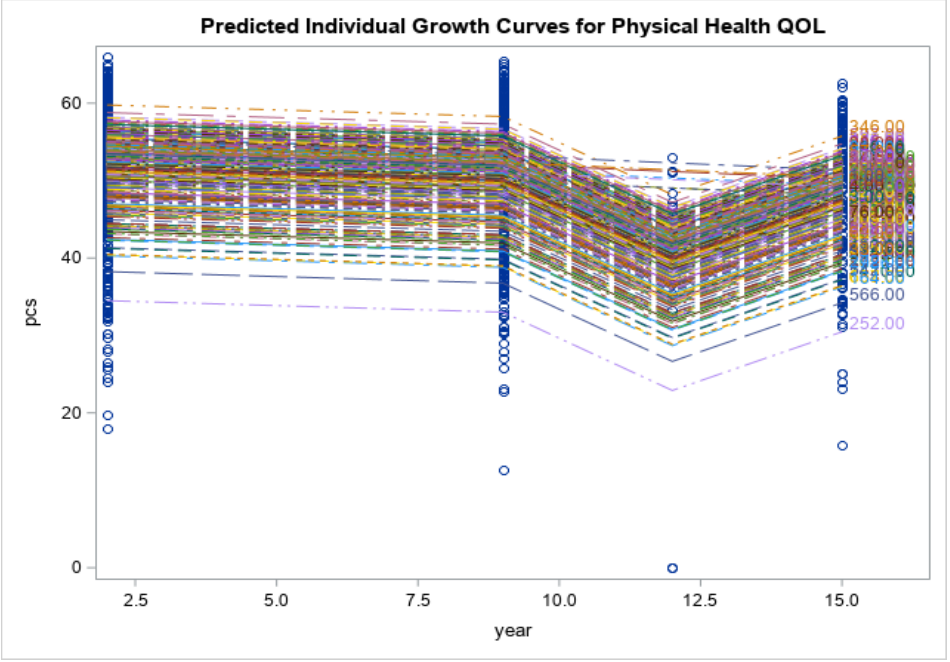
Figure 5. Predicted individual growth curves for K10. The blue lines indicate the measurement time points.